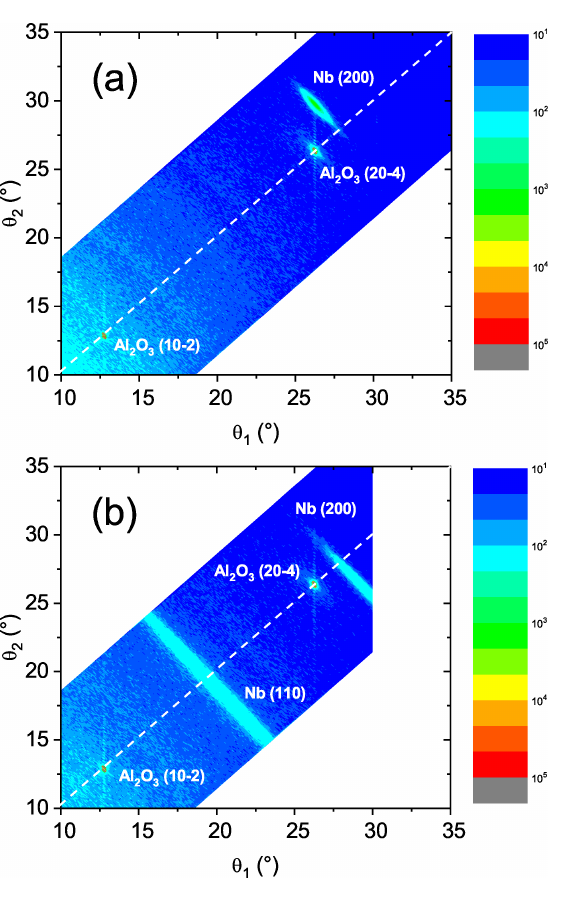
Figure 2: RHEED patterns of (a) the Al 2 O 3 ( ) substrate, (b) the Pt cap layer, and the Nb buffer layer grown at (c) 800 °C and (d) 30 °C. (e, f) Growth stages of sample s6: (e) the 6th Fe layer, (f) the 6th Nb layer.